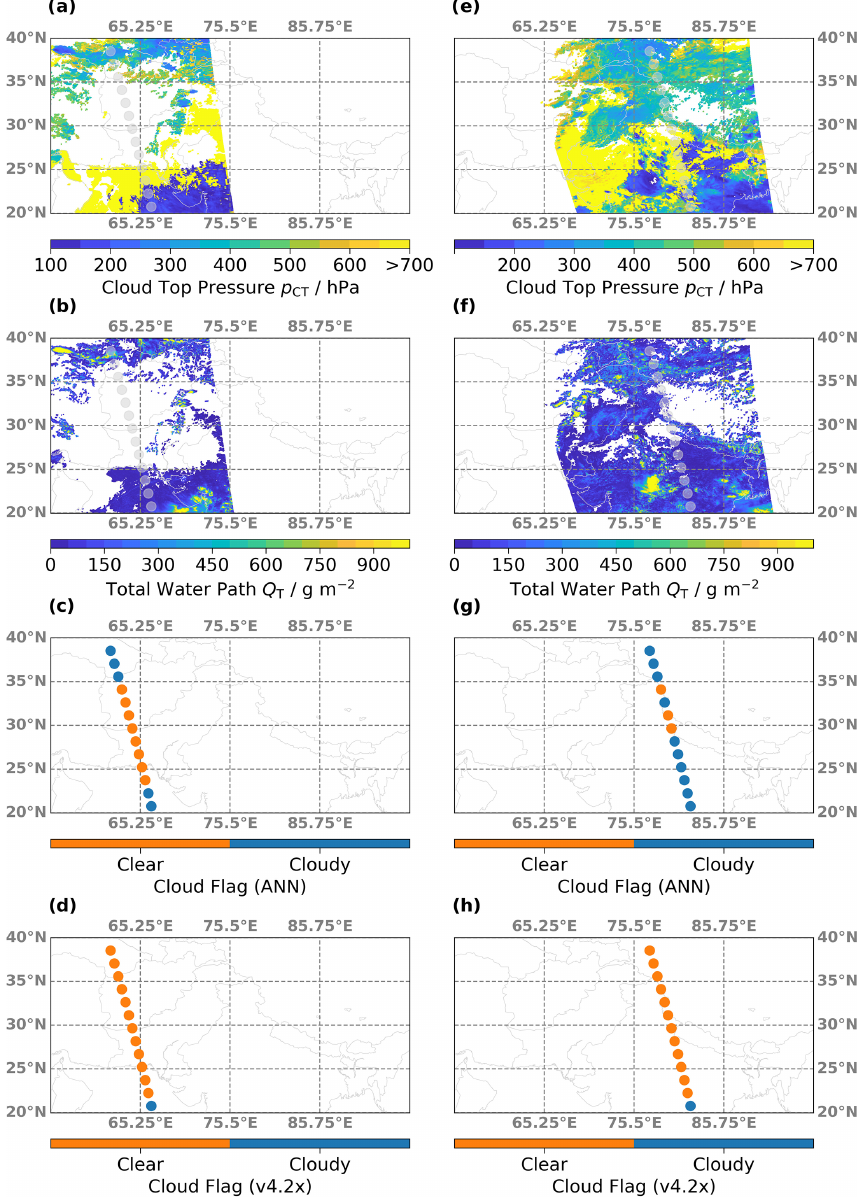
Figure 9. Similar to Fig. 8 but for MLS and MODIS observations on (a–d) 28 June 2019 and (e–h) 5 July 2018, respectively, over South Asia. These scenes were captured over the Asian summer monsoon